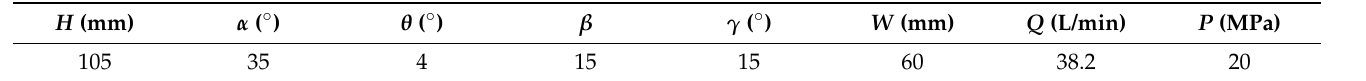
(3)–(16) are shown in Table 1. Table 1. The descaling process parameters of hot rolling. Table 1. The descaling process parameters of hot rolling.